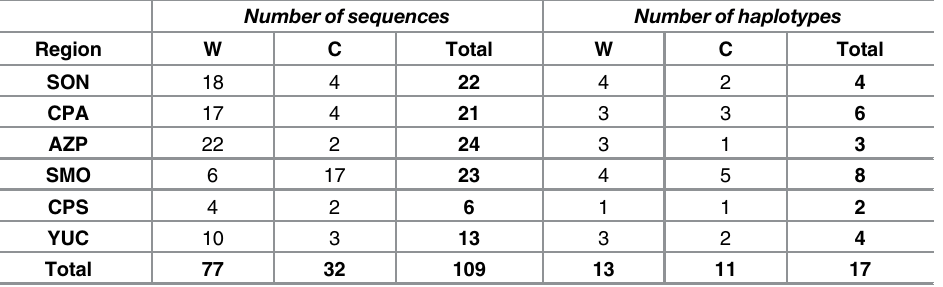
Region indicates the biogegraphical province: Sonora (SON), Costa del Pací fi co (CPA), Costa del Pací fi co Sur (CPS), Altiplano Zacatecano-Potosino (AZP), Eastern side of the Sierra Madre Oriental (SMO), Yucatan (YUC). W = Populations from wild habitats, C = Cultivated